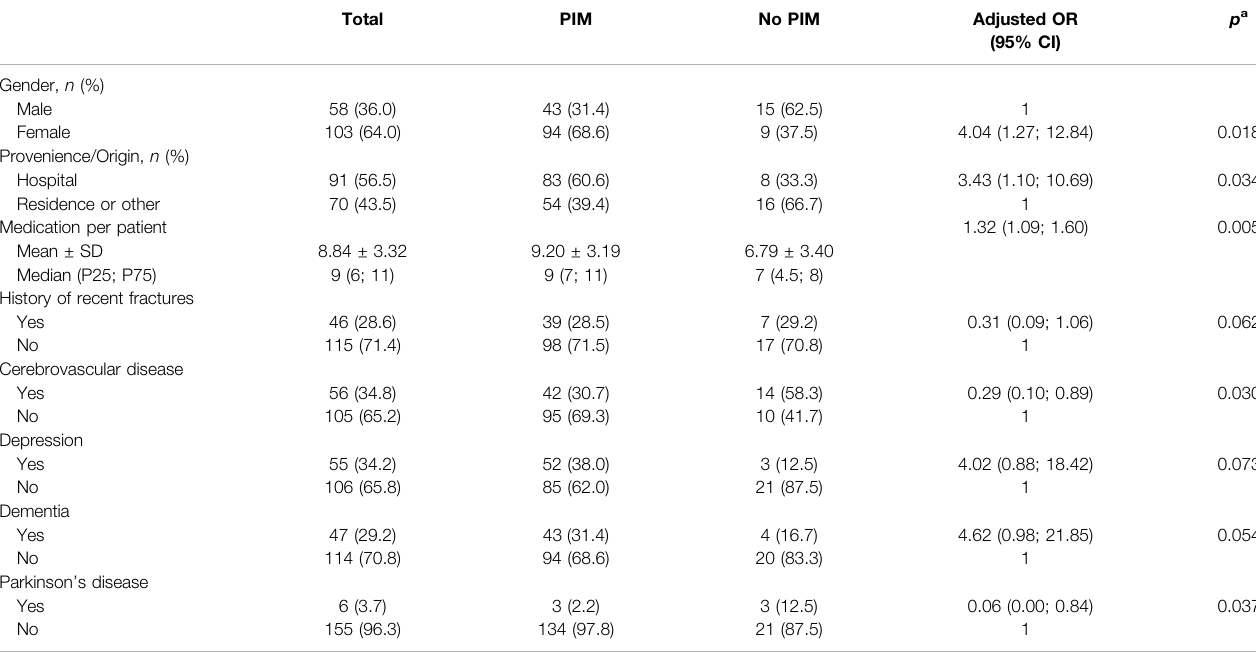
TABLE 6 | Predictors of potentially inappropriate medications (PIMs), according to Screening Tool of Older People ’ s Prescriptions (STOPP) criteria, in the study population ( N (cid:1)